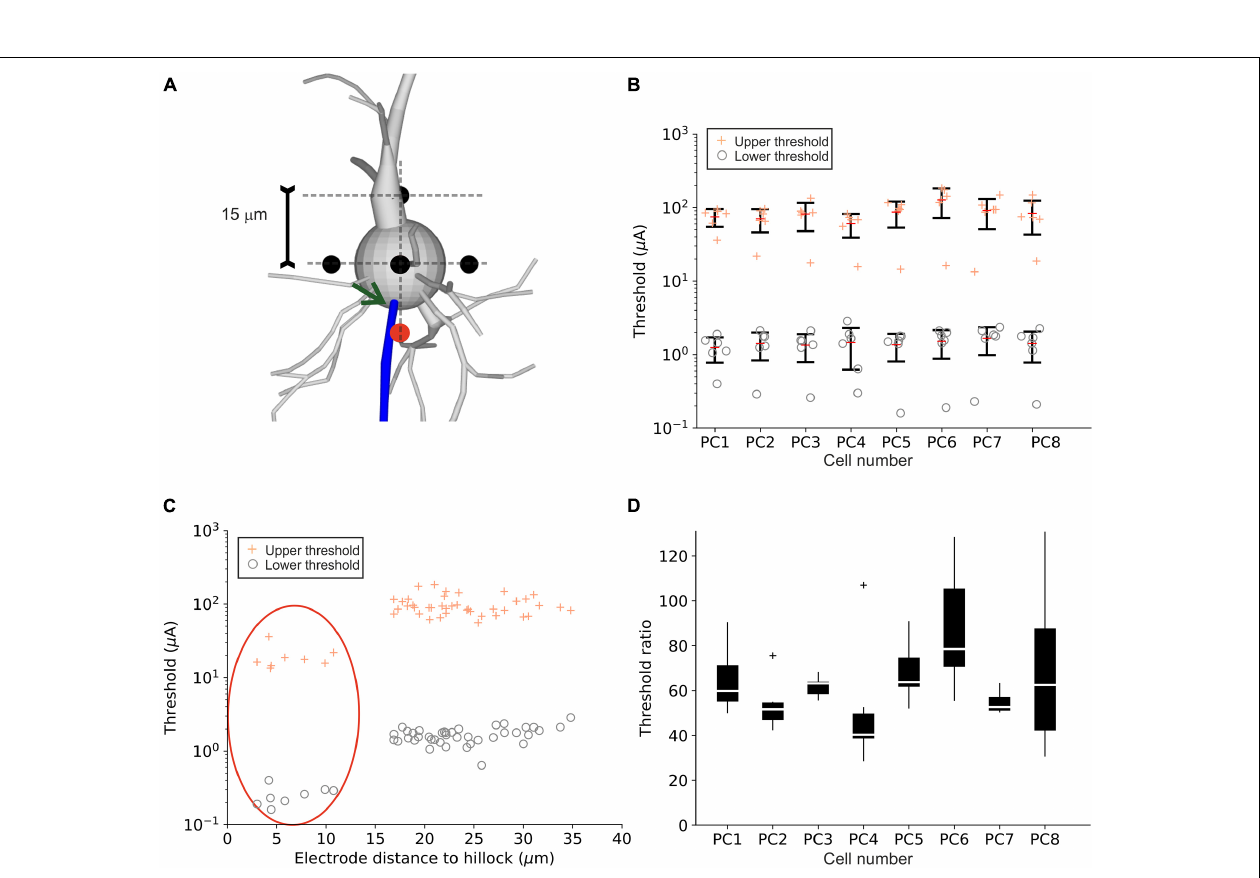
FIGURE 5 | Electrode size and pulse configuration affect threshold ratios in RGCs. (A) Threshold ratio vs. electrode diameters ranging from 10 to 200 µ m. (B) Threshold ratio of monophasic and charge balanced biphasic pulses plotted vs. the ratio 0.1/D ano .